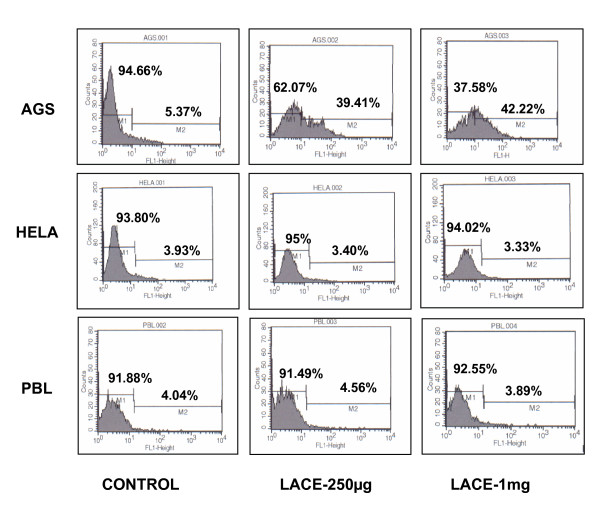
Flow cytometric analysis of apoptotic populations using anti-active caspase 3 antibody. AGS and HELA tumor cell lines were treated with 250 μg/ml or 1 mg/ml of LACE. Data indicate the percentage of cells positive for presence of active-caspase-3. Results are representative of three experiments